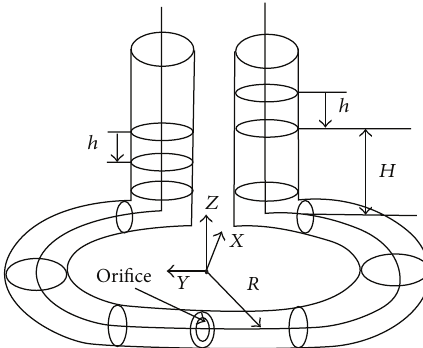
Figure 9: The circular tuned mass damper